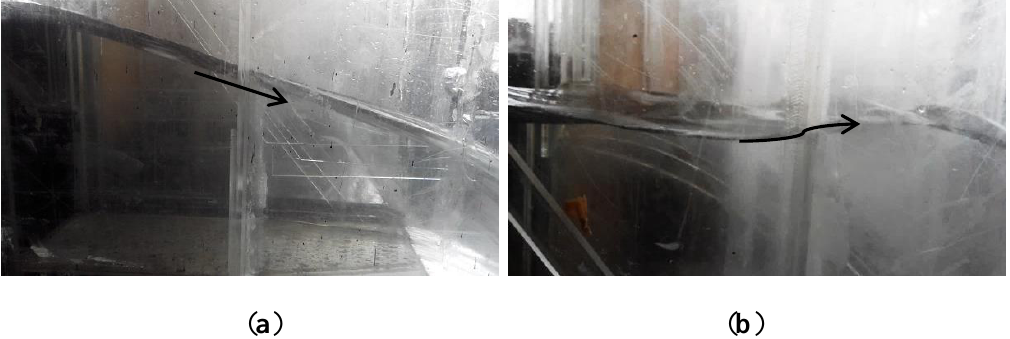
Figure 5. Photograph of water surface: ( a ) without FGP; ( b ) with FGP ( β = 0.51, θ = 15°) (Black arrow stands for the flow direction).